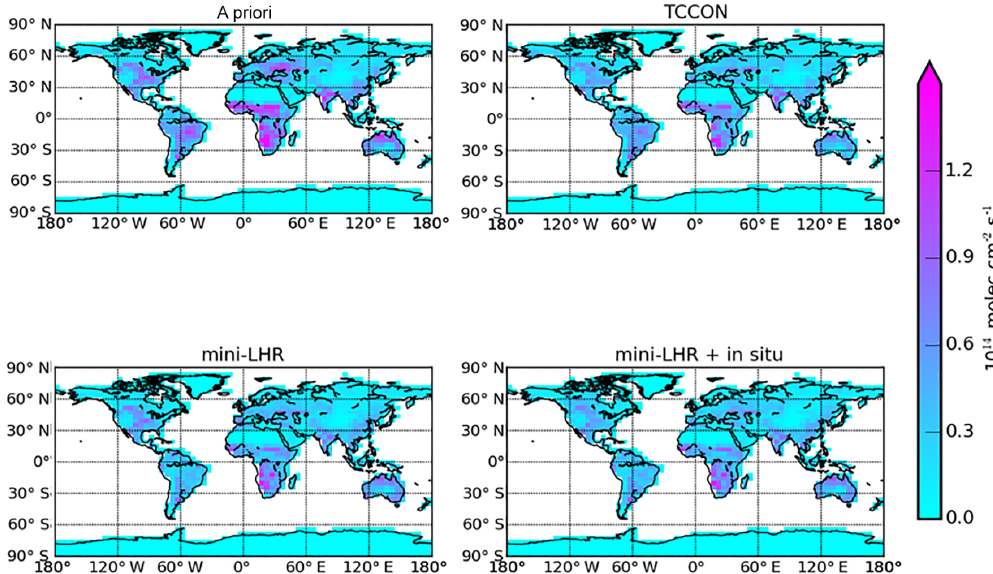
Figure 7. Distribution of annual mean root-mean-square errors between the true state and a priori and a posteriori CO 2 fluxes